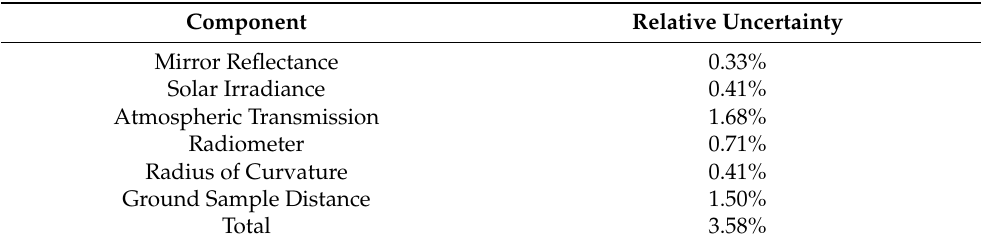
Figure 9. The extracted radiance ( A ) for the 1 mirror floating target (dashed line) agrees with the SPARC predicted at-aperture radiance (solid line) over most of the VISNIR spectral range. Similarly for reflectance calibrated imagery ( B ), the extracted (Ext) spectra (dashed lines) correspond well with the predicted reflectance (LER) for 1, 3, and 4 mirror targets (solid lines). Retrieved spectra have not been smoothed. Shaded regions correspond to a conservative first-order estimate k = 1 uncertainty of the measurement. Table 3. Airborne Uncertainty Budget-Primary Factors, 500